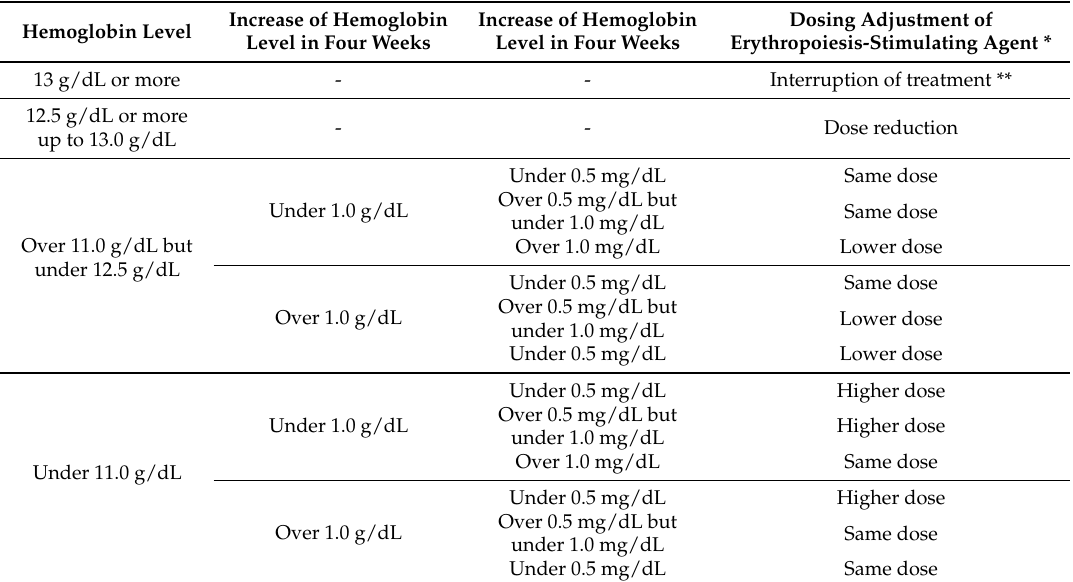
Table 5. Dosing adjustment